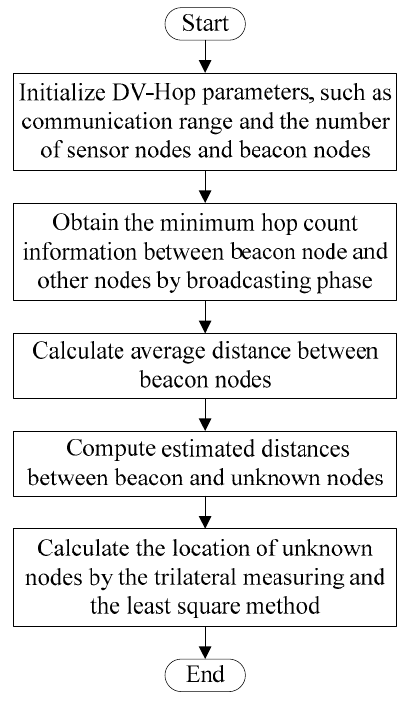
Figure 1. The distance vector-hop technique (DV-Hop) flowchart.